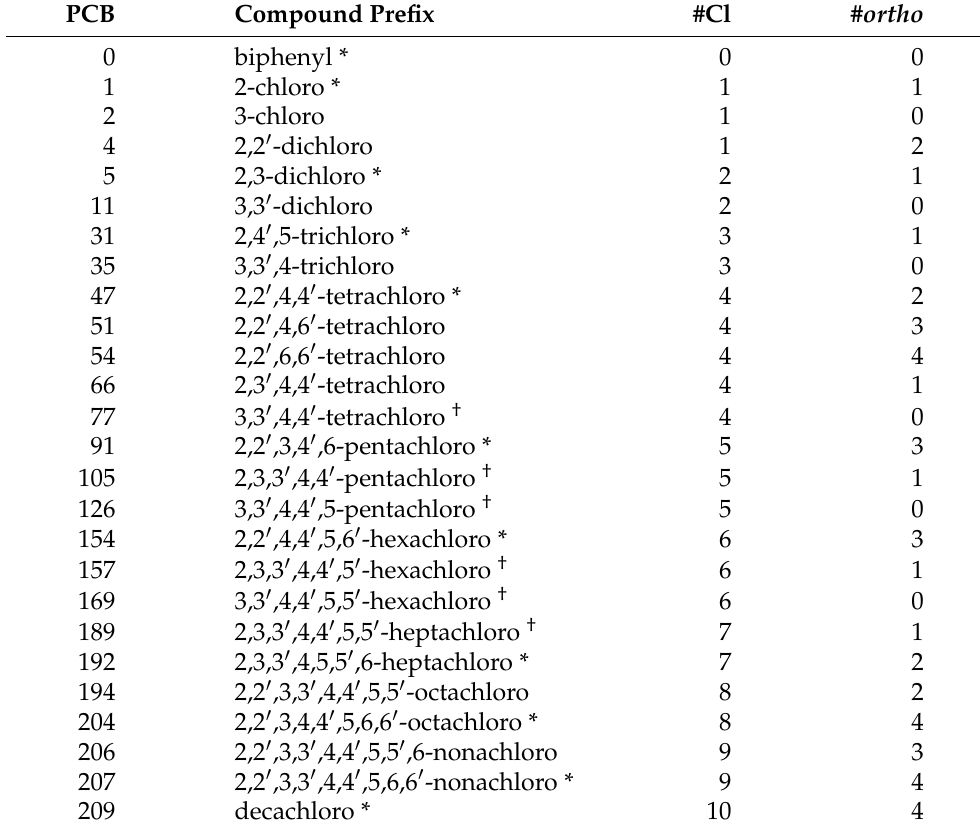
Table 1. PCBs considered in this work. (*) PCBs tested in the experiments. ( † ) Dioxin-like PCBs. PCB numbers are assigned according to the standard scheme of Ballschmiter et al. [54] The number of chlorine atoms and the number of ortho -substituted chlorine atoms are given for each compound. Structures are shown in Figure